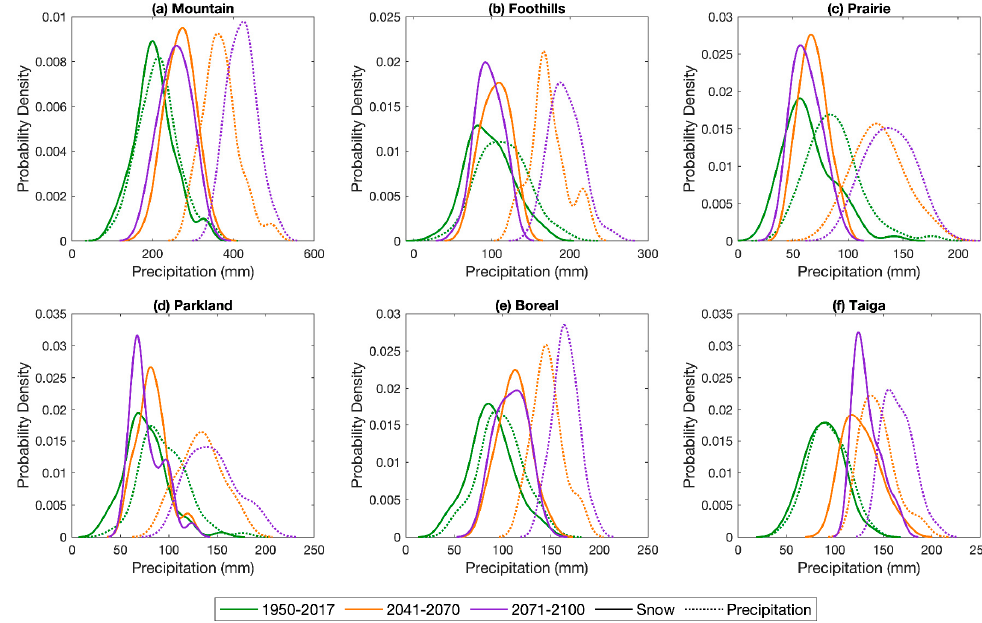
Figure 12. Probability density function of total November–April snowfall (solid lines) and precipitation (dotted lines) amounts for historic and projected future periods under RCP 8.5.